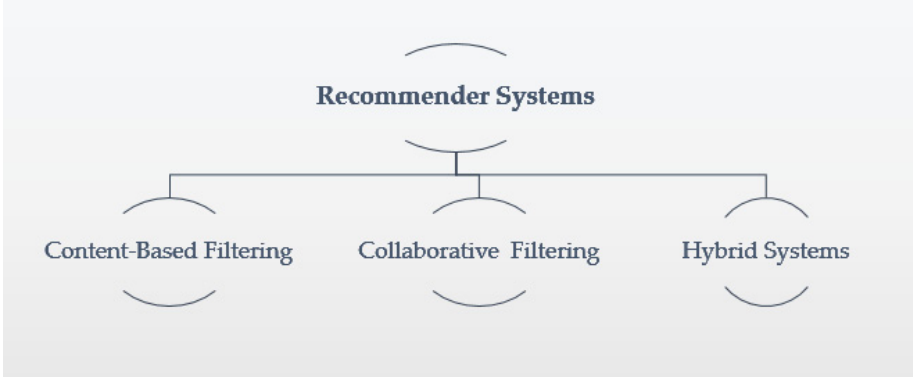
Figure 1. Structure of the recommendation systems